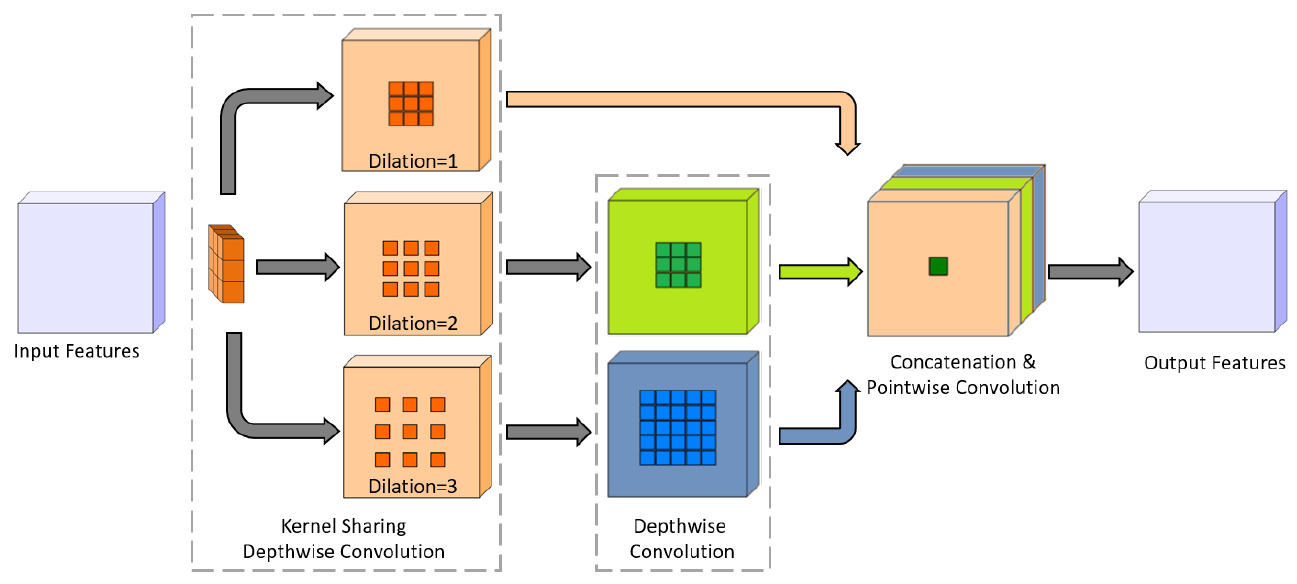
Figure 3. Structure of the MKA module. The orange square represents the kernel shared by three depthwise atrous convolutional branches with dilation rates (1, 2,